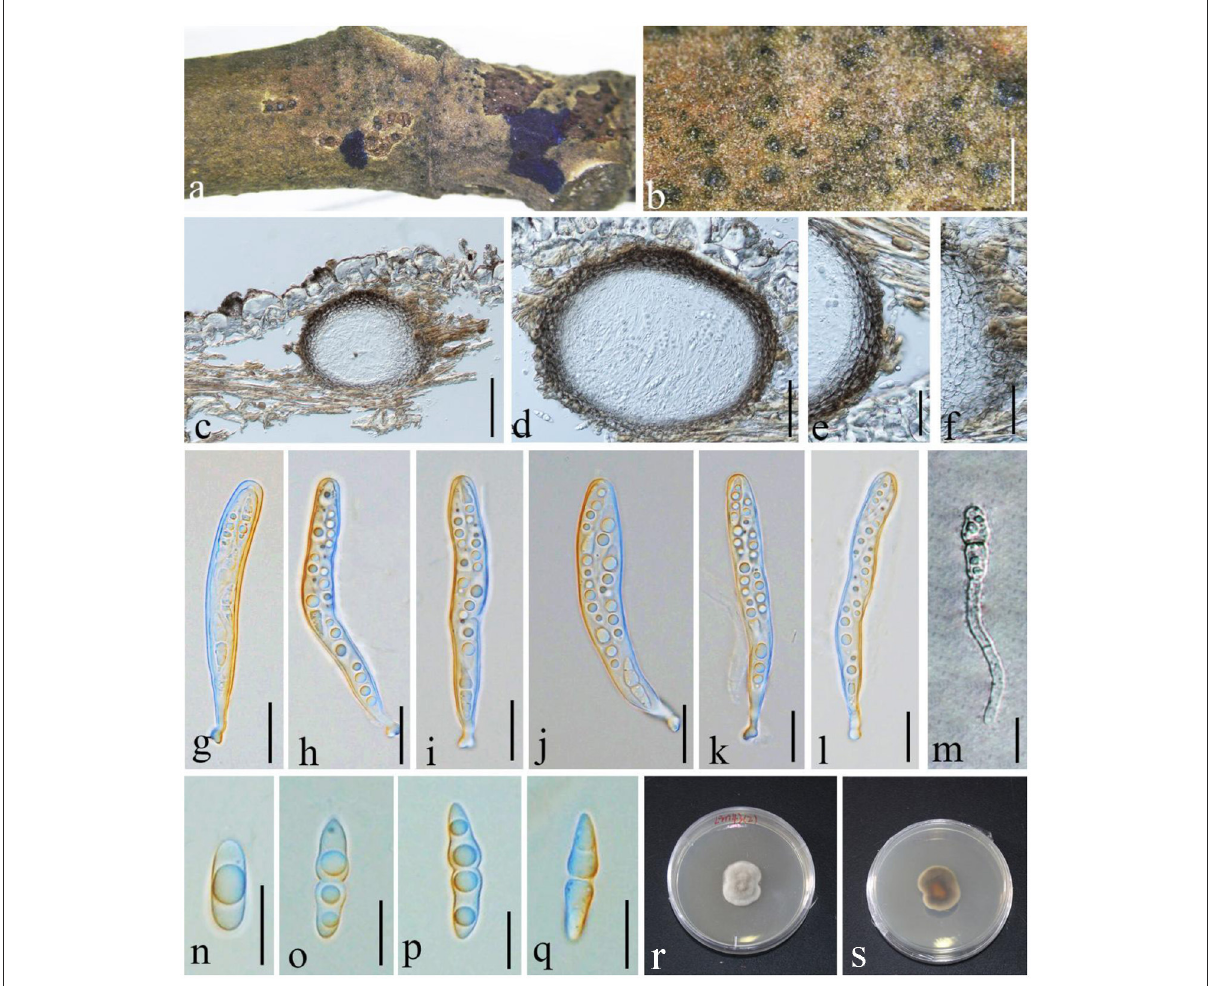
FIGURE7 Angustimassarina populi (GMB1385, new host and country record). (a,b) Ascomata on a M. grandiflora branch. (c,d) Vertical sections of ascomata. (e,f) Peridium. (g–l) Asci. (m) Germinating ascospore. (n–q) Ascospores. (r,s) Cultures on PDA [ (r) = from above and (s) = from bottom]. Scale bars: (b) = µ m, (c) = 100, (d) = 50, (e) = 30, (f) = 25, (g–l) = 20, and (m–q) = 10 µ